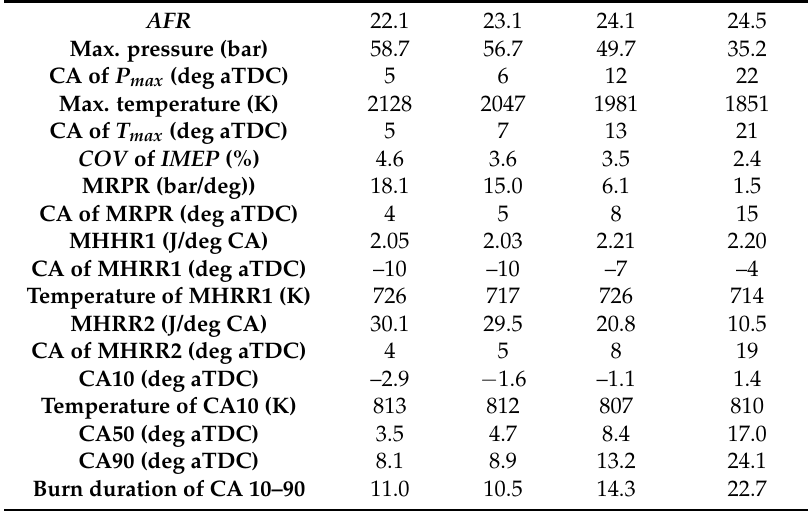
Table 4. The combustion parameters of the engine test. CA: crank angle; COV : coefficient of variation; and MRPR: maximum rate of pressure